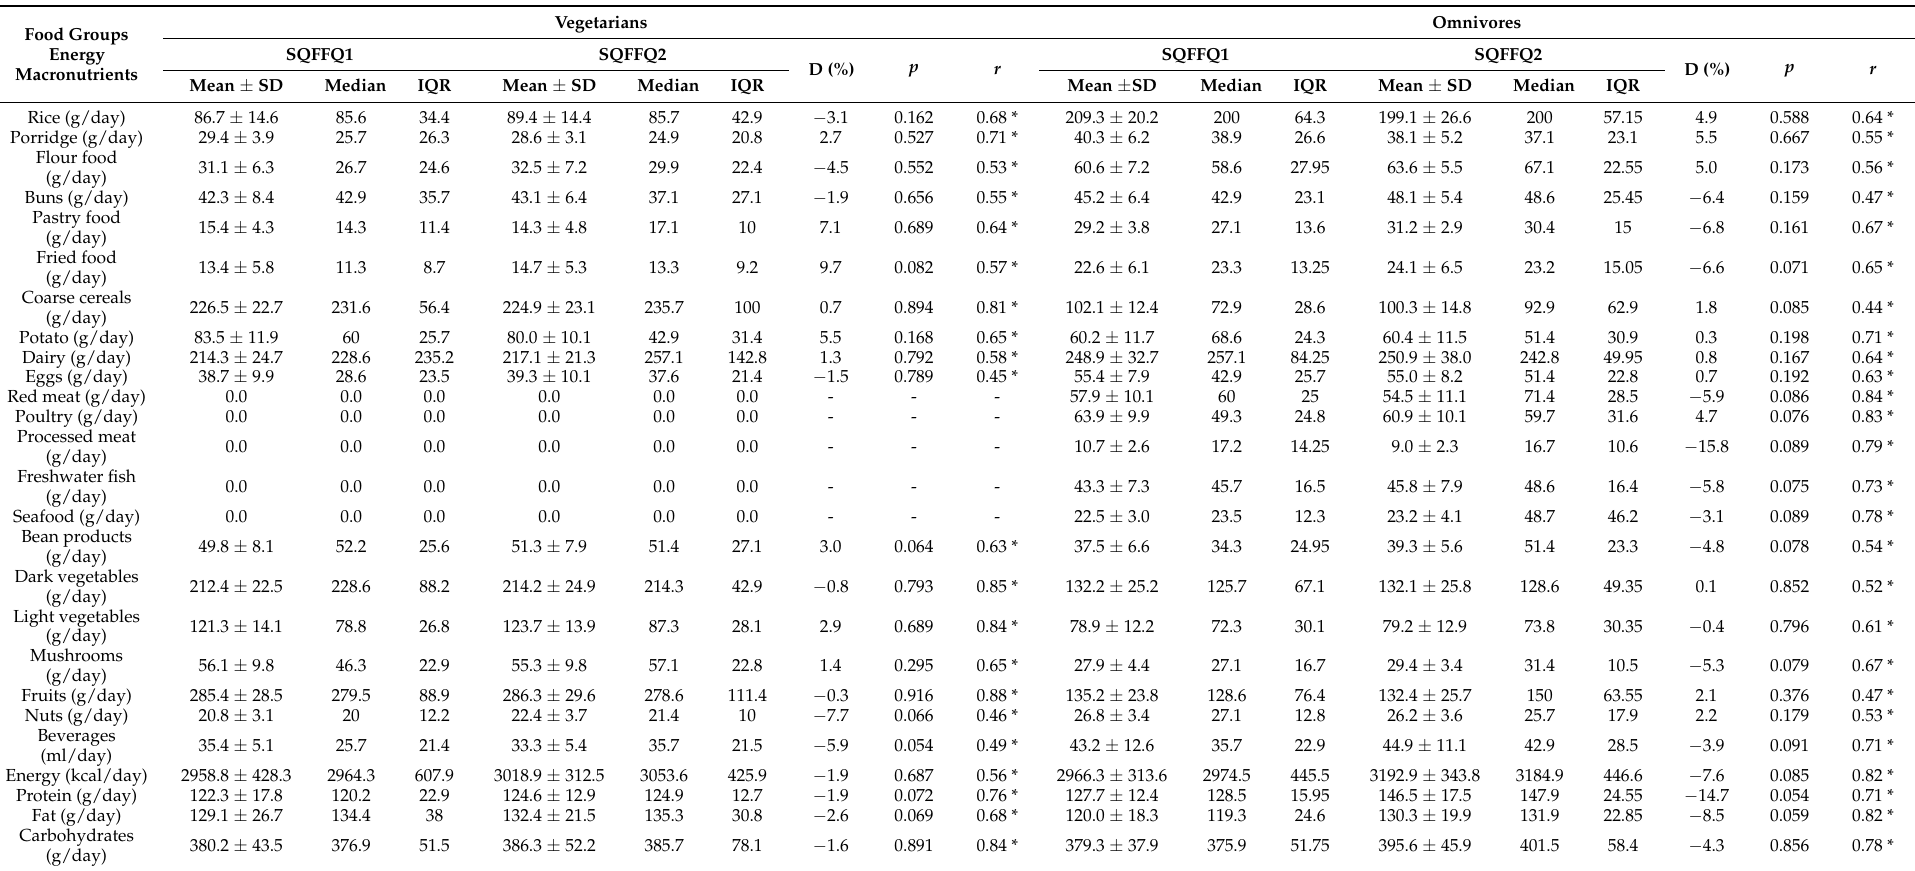
Table 3. Reproducibility study: Mean daily food intake, difference and correlation coefficients for the comparison between SQFFQ1 and